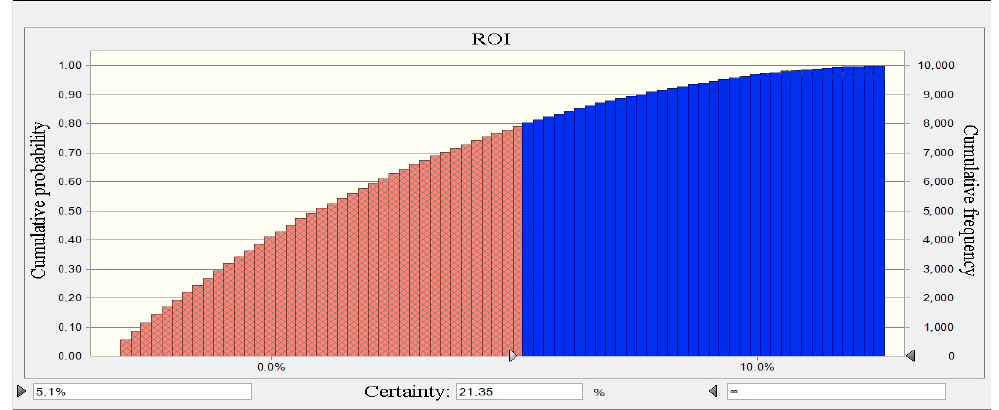
Figure 4. Cumulative probability distribution of ROI if critical levels (urban planning, technical, and administrative) are assumed for multi-family buildings before the introduction of CILAS (own elaboration).